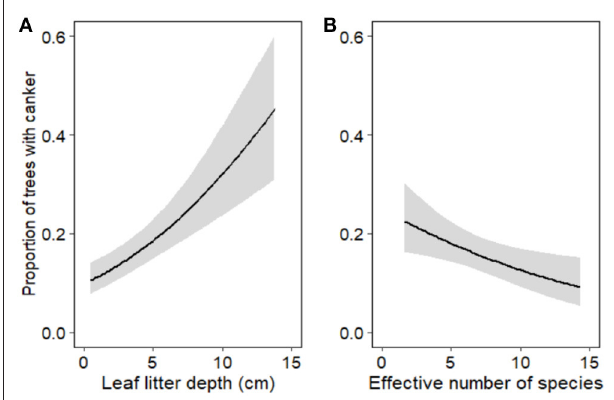
FIGURE 4 | Canker incidence in Corymbia calophylla as a function of (A) leaf litter depth (cm) and (B) effective number of species (exponent of Shannon diversity) of ectomycorrhizal (ECM) fungi. Lines indicate mean fitted values extracted from the best fit model and gray ribbons represent 95% confidence intervals about the